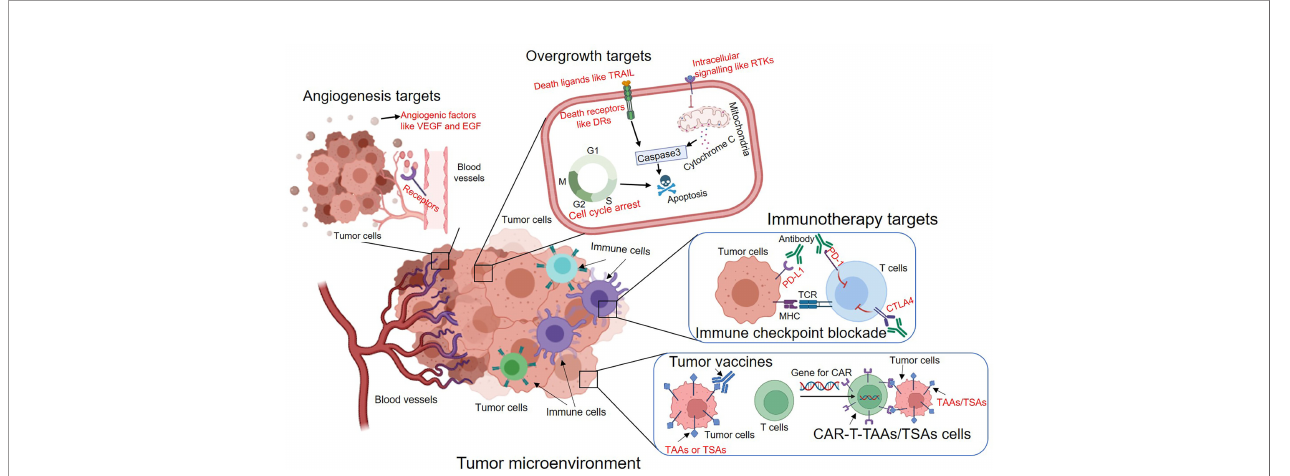
FIGURE 1 | The overview of major types of molecular targeted therapies to inhibit tumour angiogenesis, overgrowth and immune evasion. The potential targets are indicated in red. VEGF, Vascular endothelial growth factor; EGF, Epidermal growth factor; TRAIL, TNF-related apoptosis-inducing ligand; DRs, Death receptors; RTKs, Receptor tyrosine kinases; PD-1, Programmed cell death protein 1; PD-L1, Programmed death-ligand 1; CTLA4, Cytotoxic T-Lymphocyte Associated Protein 4; TAAs, Tumor-associated antigens; TSAs, Tumor-speci fi c